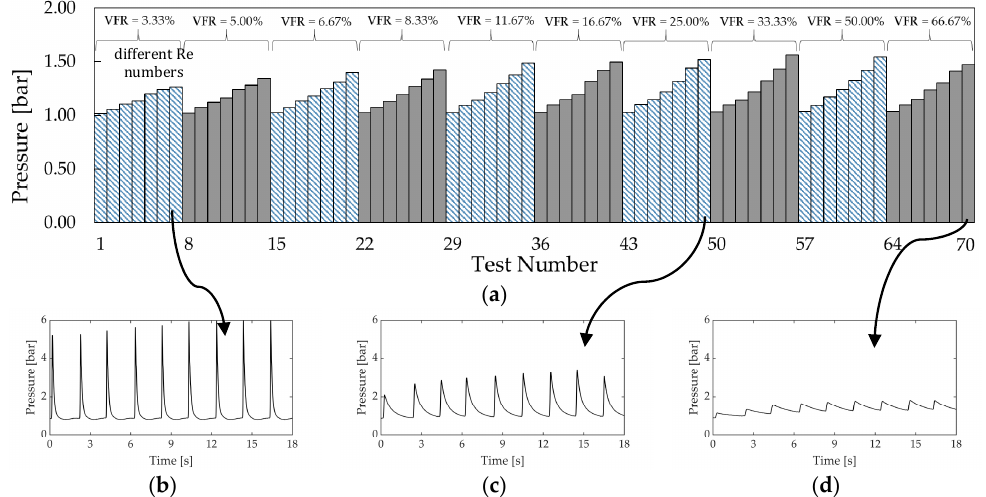
Figure 6. The concept of average and real-time air pressure: ( a ) average pressure for different VFR and Re numbers; ( b ) p air for VFR = 3.33% and Re = 155,000; ( c ) p air for VFR = 25.00% and Re = 155,000; ( d ) p air for VFR = 66.67% and Re =